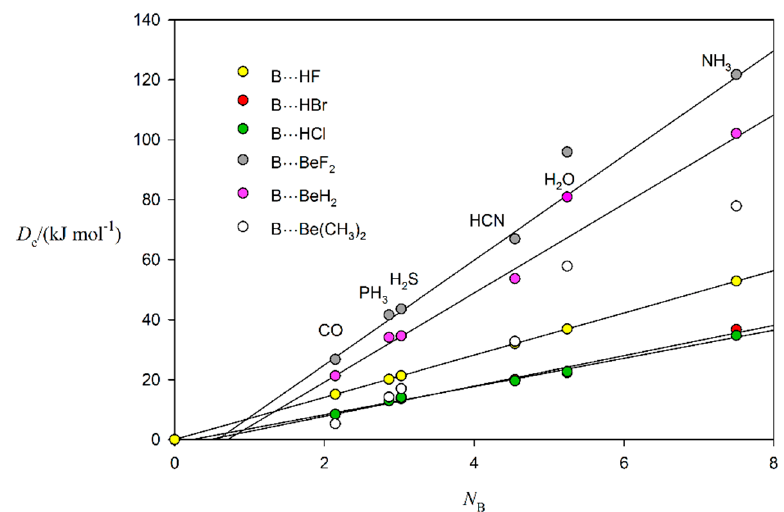
Figure 9. D e versus the nucleophilicity, N B , for the series B ··· BeR 2 and B ··· HX complexes (B = CO, HCN, H 2 O, NH 3 , H 2 S and PH 3 ; R = F, H or CH 3 ; X = F, Cl or Br). The N B values are defined by the B ··· HF straight line through the origin (see text for details). The points for H 2 O ··· BeR 2 were excluded from the regression fits for reasons discussed in the text. The regression lines and points for B ··· HCl and B ··· HBr are almost coincident. To avoid congestion, the regression line for the B ··· Be(CH 3 ) 2 points has been omitted. ( R 2 = 0.994, 0.996, 0.998, 1.000.0.993 and 0.988 for Be(CH 3 ) 2 , BeH 2 , BeF 2 , HF, HCl and HBr lines, respectively). Table 3. Nucleophilicities of six Lewis bases, B, and electrophilicities of nine Lewis acids, A.